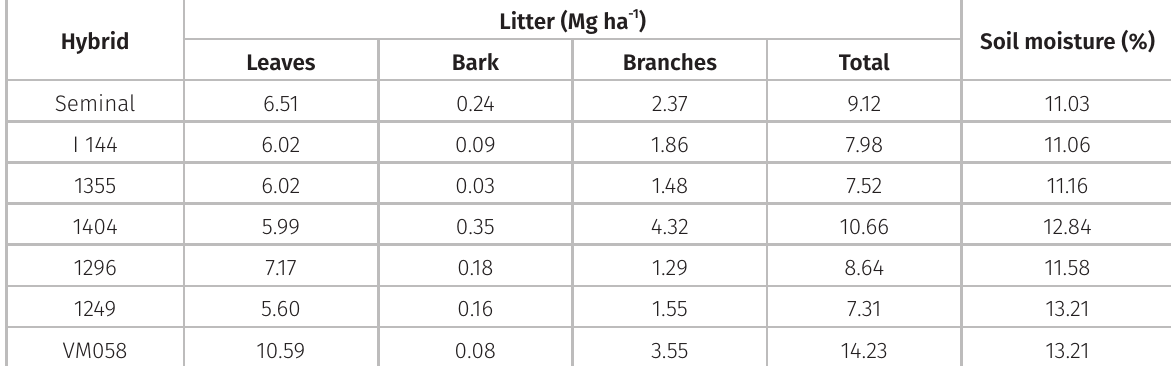
Table III. Accumulated litter and soil moisture associated with different four-year-old Eucalyptus hybrids in Vitória da Conquista –